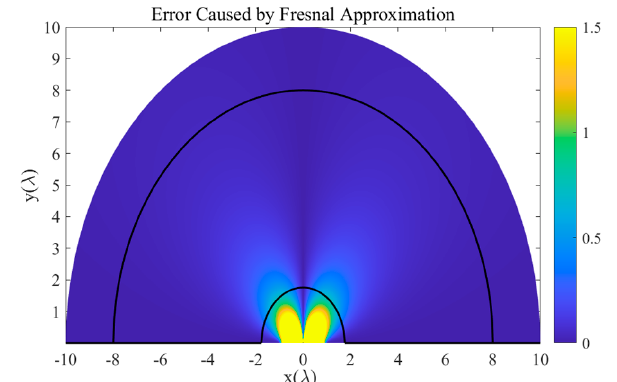
Figure 1. Phase difference error introduced by Fresnel approximation. Figure 1. Phase di ff erence error introduced by Fresnel